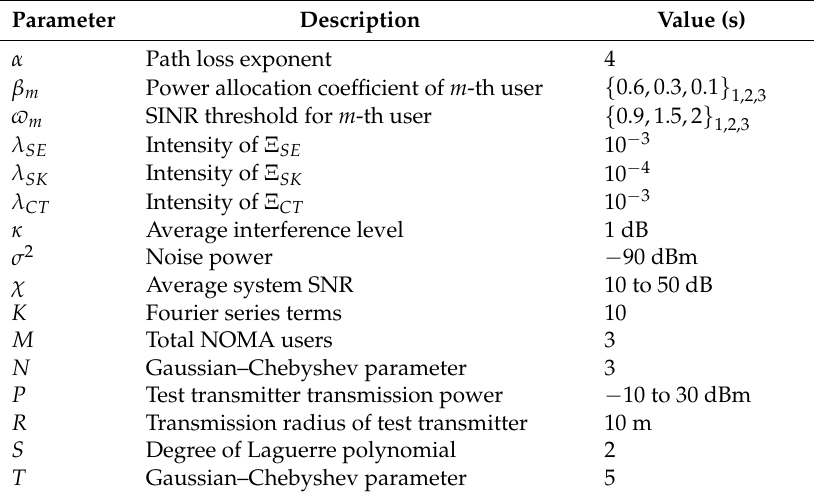
Table 2. Simulation